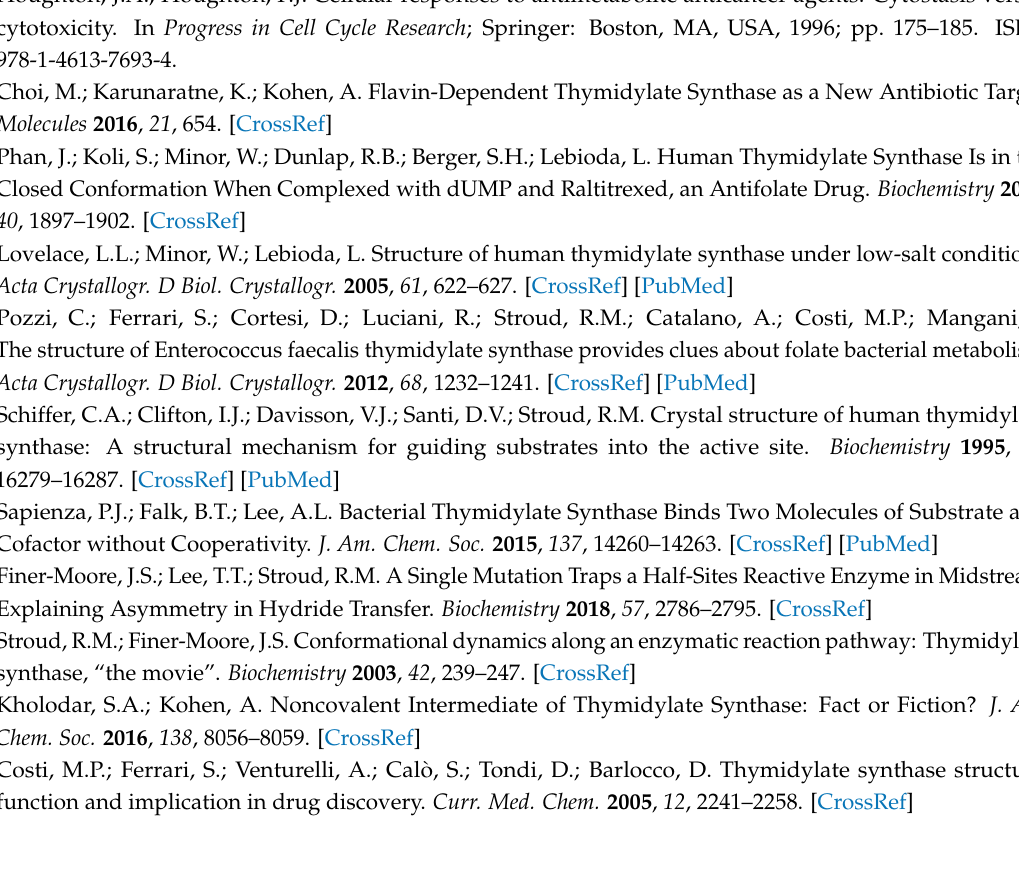
Supplementary Materials: Figure S1: structural comparison of the 5-FTHF binding mode; Figure S2: Sequence alignment among TSs from different sources; Table S1: Data collection and processing statisctics; Table S2. Structure solution and refinement